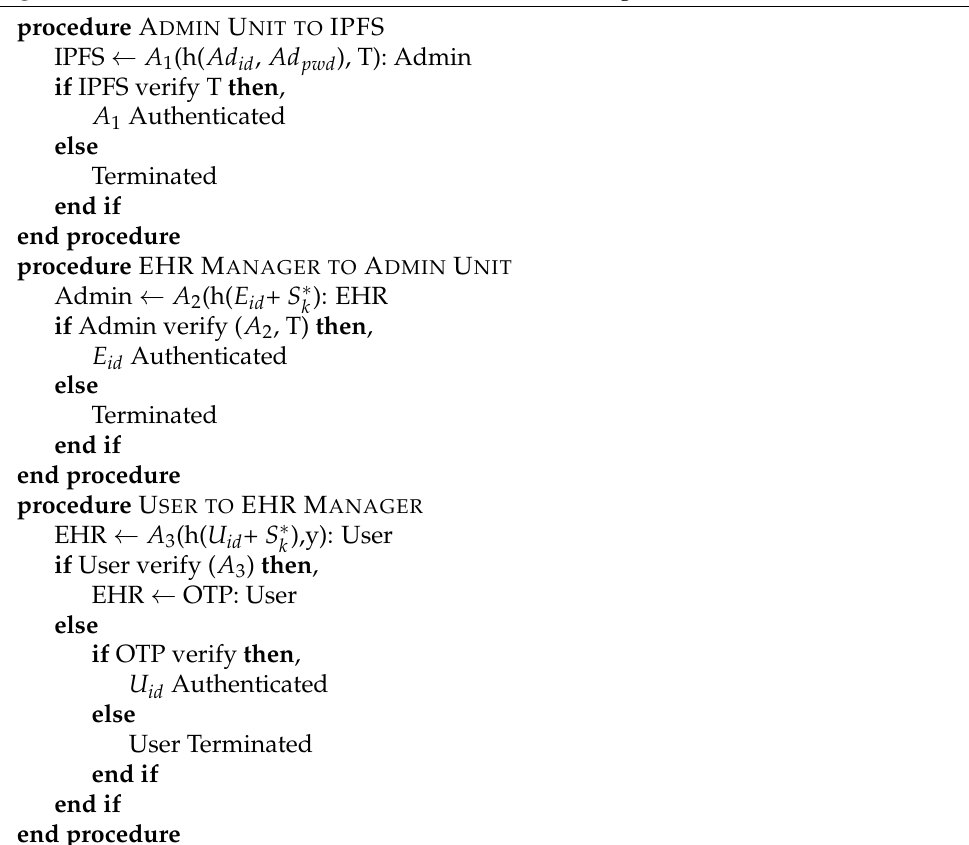
Algorithm 2 Authentication Between Admin, EHR manager, and User procedure A DMIN U NIT TO